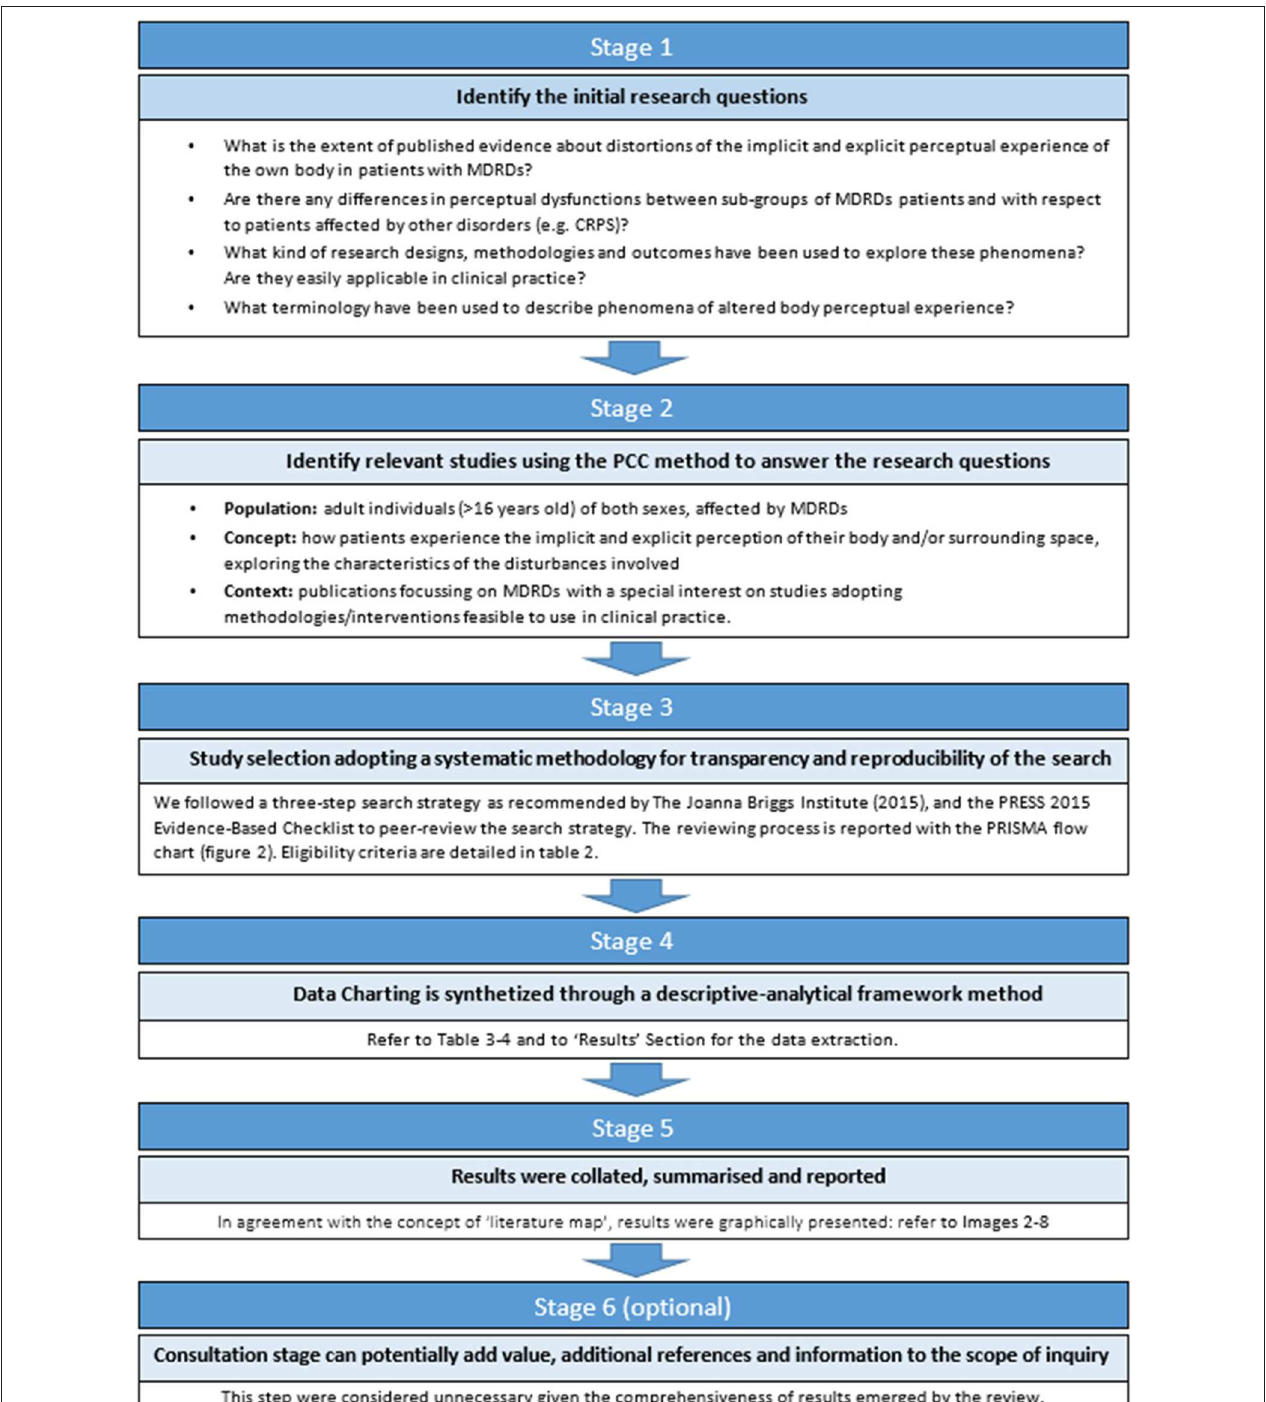
FIGURE 1 | Summary of the adopted guidance framework for scoping